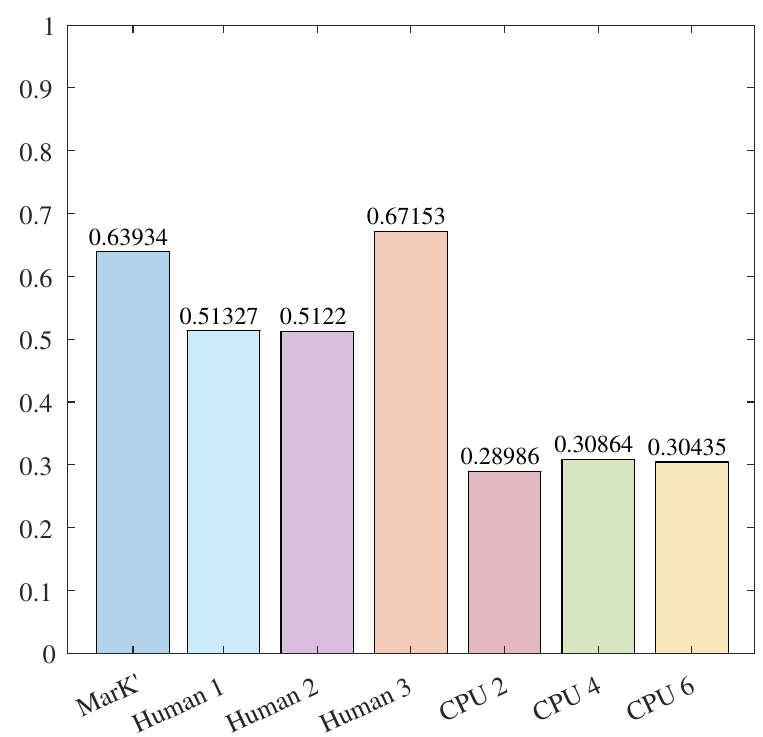
Figure 6. Computed human-likeness ratios for the third-person Turing